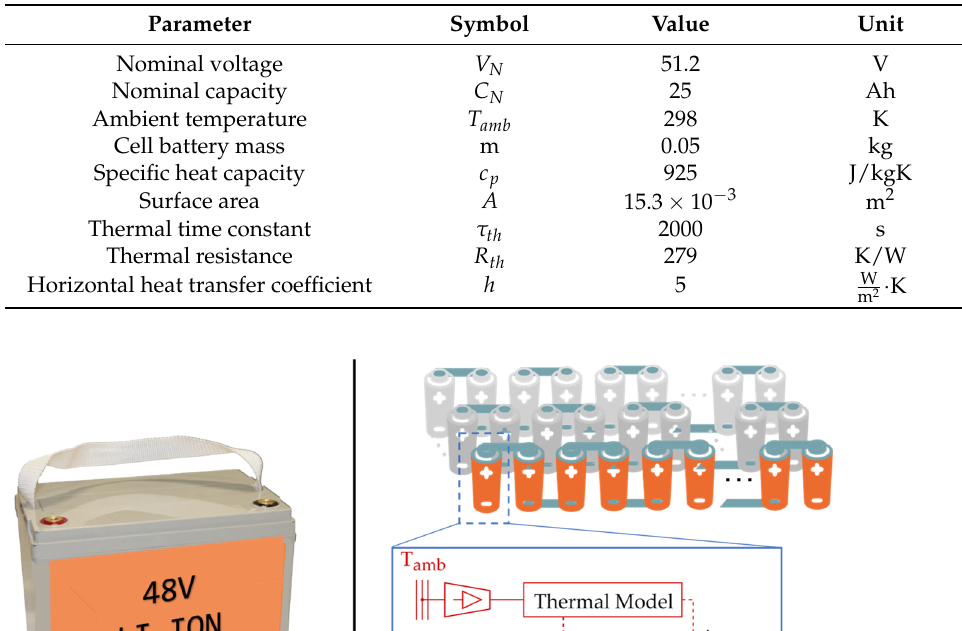
Table 1. Main parameters of the retained battery model.